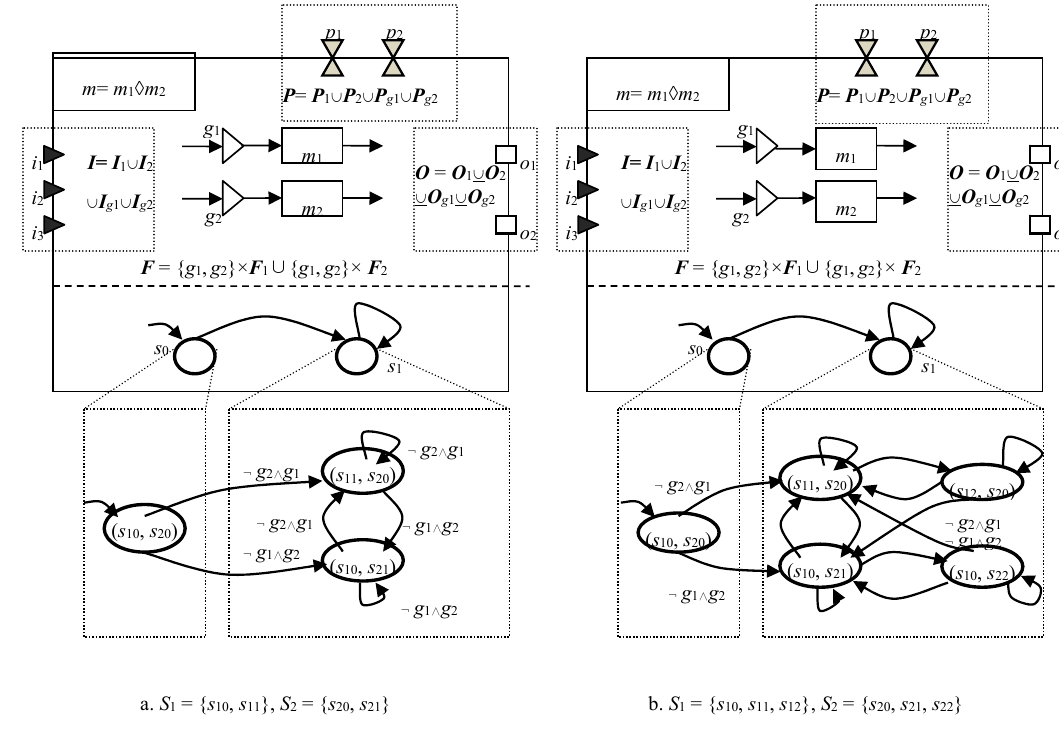
Figure 9. The diagram definition of the Select operator. ( a ) S1 = {s 10 , s 11 }, S2 = {s 20 , s 21 }; ( b ) S1 = {s 10 , s 11 , s 12 }, S2 = {s 20 , s 21 , s 22 }.